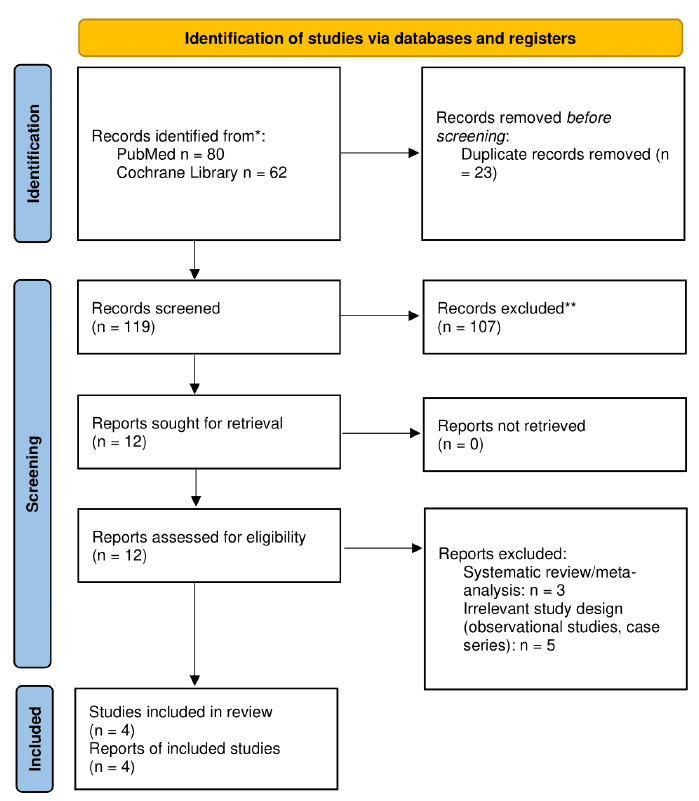
Figure 1. Flow diagram depicting the study selection process.